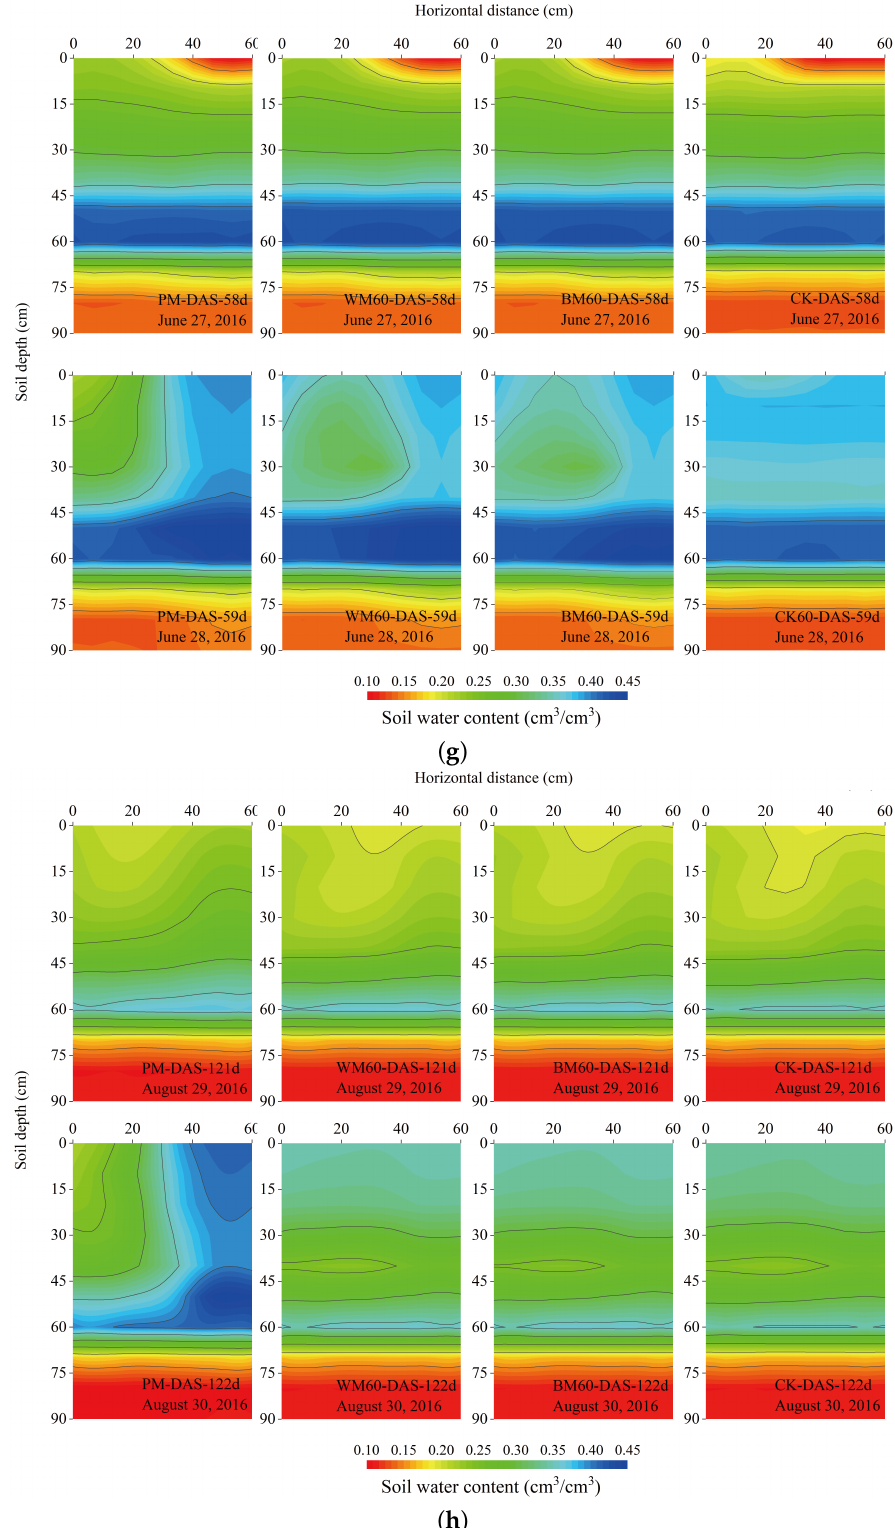
Figure 3. Dynamic change of soil moisture content before and after precipitation treated by different types of mulching. Moderate precipitation: ( a ) 7 July 2017, ( b ) 25 July 2018, ( c ) 23 August 2017. Heavy precipitation: ( d ) 4 July 2018, ( e ) 27 July 2016, ( f ) 11 August 2018. Extremely heavy precipitation: ( g ) 28 June 2016, ( h ) 30 August